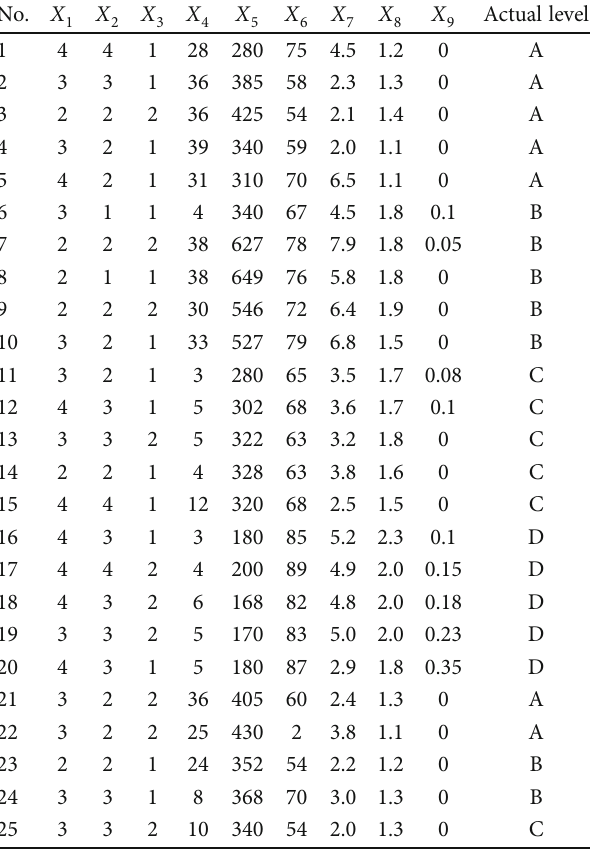
Table 1: Data about in fl uencing factors of top-coal drawing